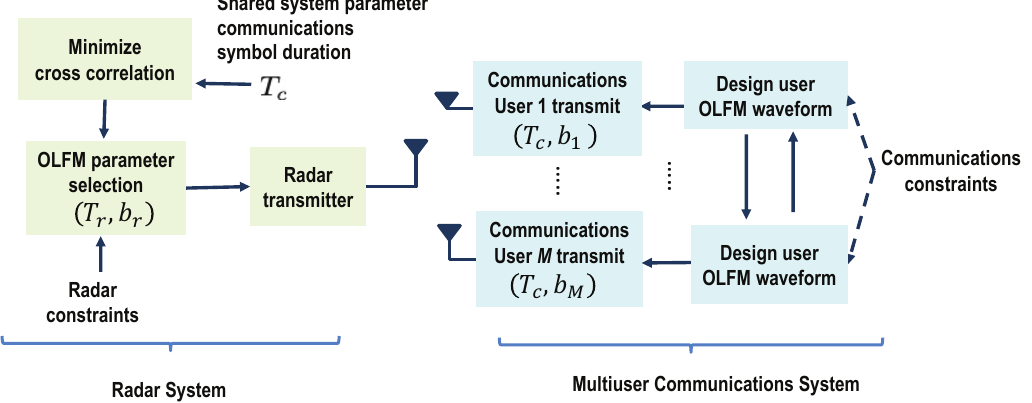
Figure 3. Block diagram overview of coexistence waveform design Approach I-A: The radar receiver has knowledge of the OLFM waveform duration, T c , that is common to all M communications